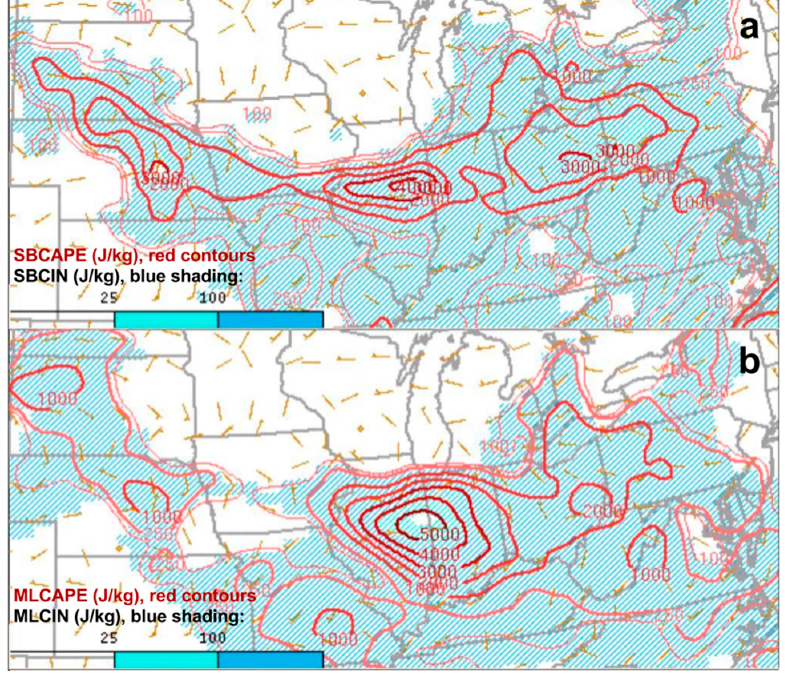
Figure 7. SPC experimental RAP analysis of 15Z 29 June 2012 for ( a ) surface-based CAPE (red isolines in J kg − 1 ) and CIN (blue shading in J kg − 1 ) values and ( b ) mixed layer (ML) CAPE and CIN values both in J kg − 1